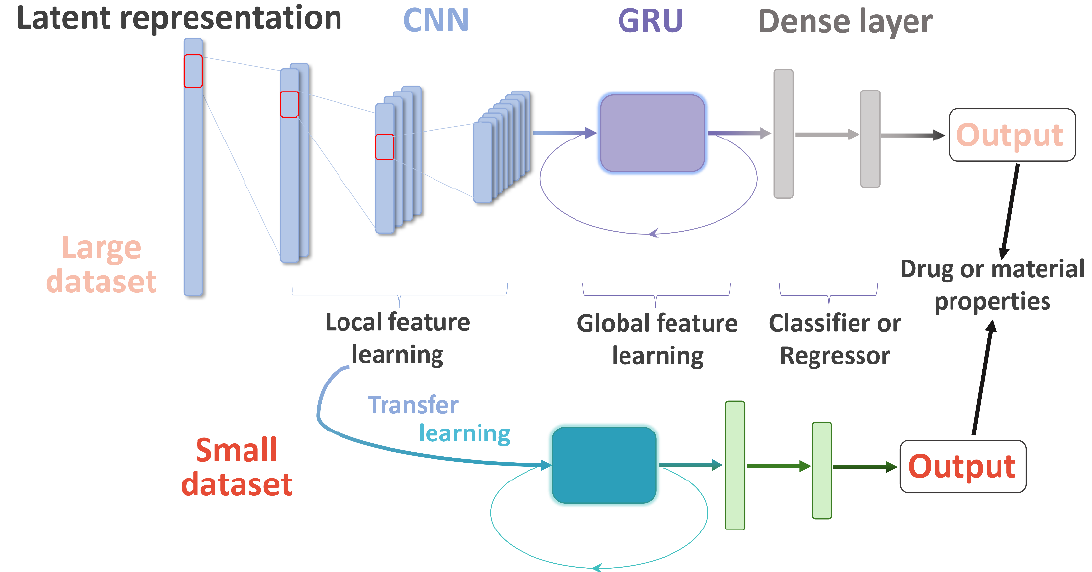
Figure 1. The architecture of CRNN and transfer learning method between large and small datasets.